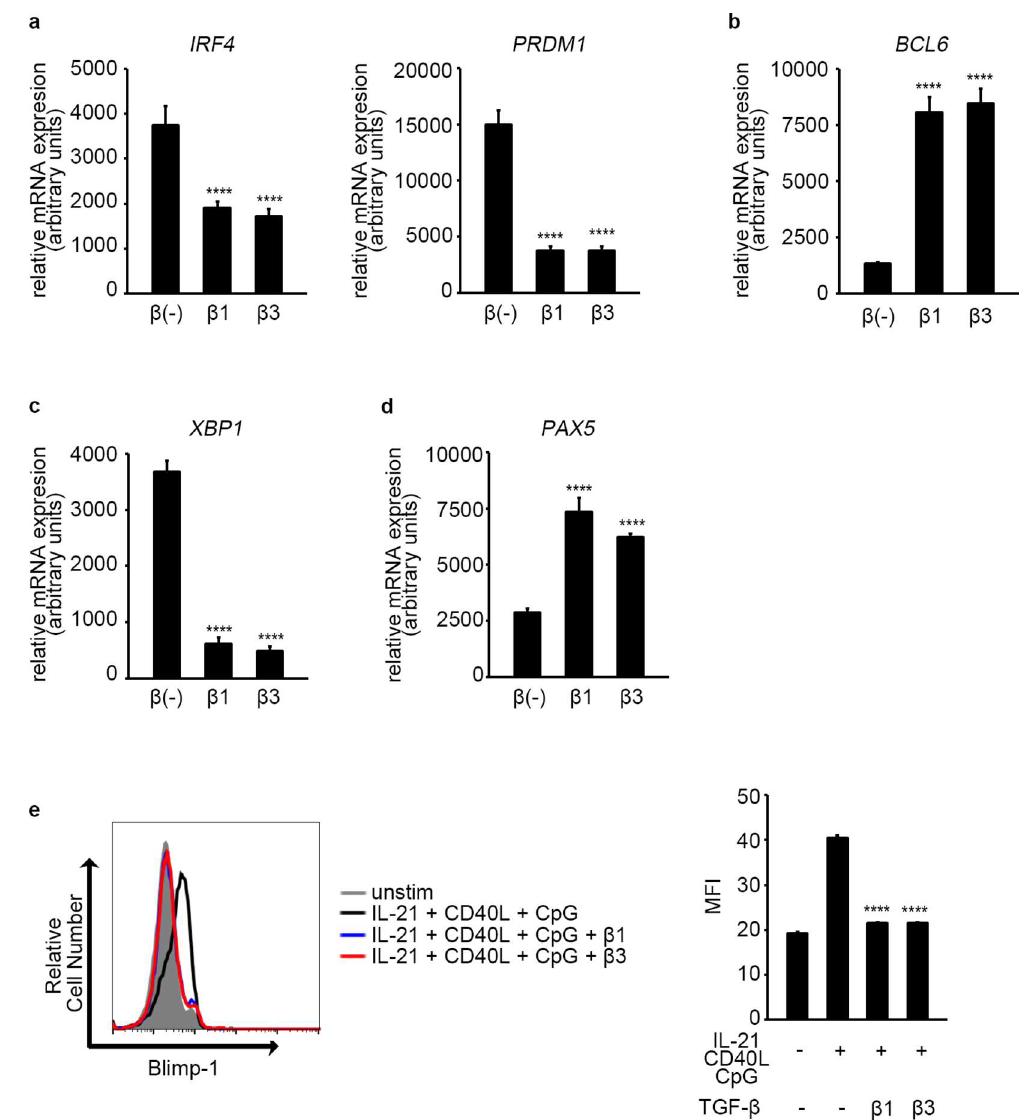
Fig 6. TGF- β 1 and β 3 inhibit TFs essential for B cell differentiation into ASCs. (a-d) B cells were cultured under IL-21 and CD40L stimulation for 3 days (a, b) or 5 days (c, d), and the expressionof the indicatedgeneswas assessedby quantitative PCR. Expression relative to GAPDH is shown. TGF- β treated cells were comparedwith TGF- β untreated cells using one way ANOVA, Dunnett test (n = 5). Results are representative of two (b), three (d), or four (a,c) independentexperiments. (e) B cells were culturedunder IL-21, CD40L, and CpG-ODN2006 stimulationfor 4 days with or without TGF- β . Expression of Blimp-1 on CD19 + B cells was assessed by intracellular staining.TGF- β treated cells were comparedwith TGF- β untreatedcells using one way ANOVA, Dunnett test (n = 3). Results are representative of three similar